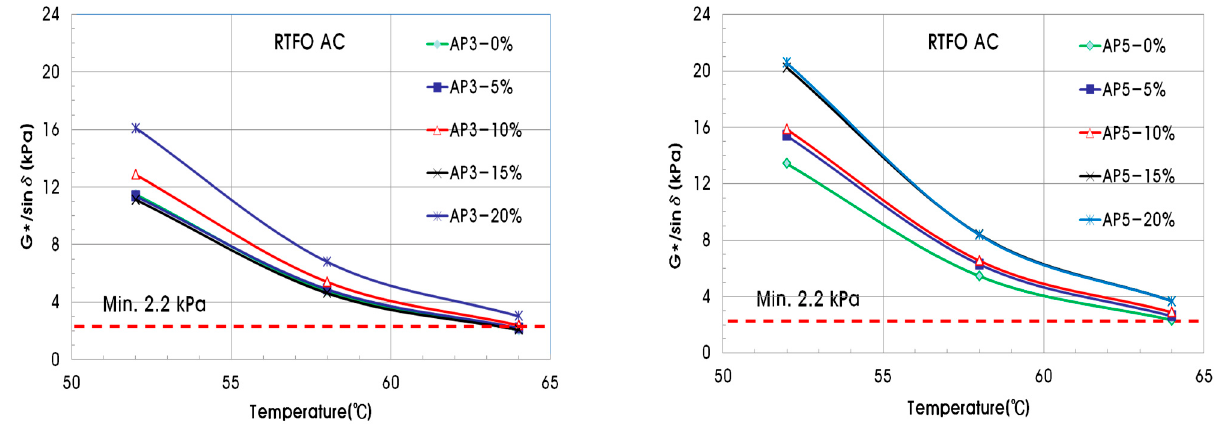
Figure 7. G*/sin δ of short-term aged asphalt binder for permanent deformation. Table 8. G*sin δ of asphalt binder for fatigue cracking.